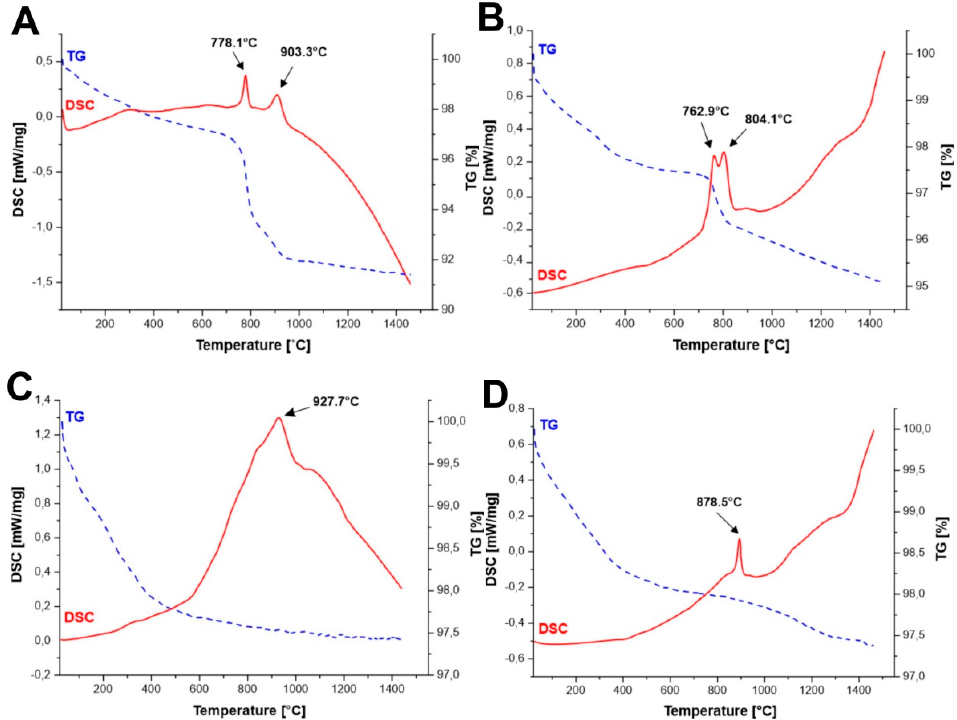
Figure 1. DSC curves of precursor powders obtained from: ( A )—Method A; ( B )—Method B; ( C )— Method C; ( D )—Method